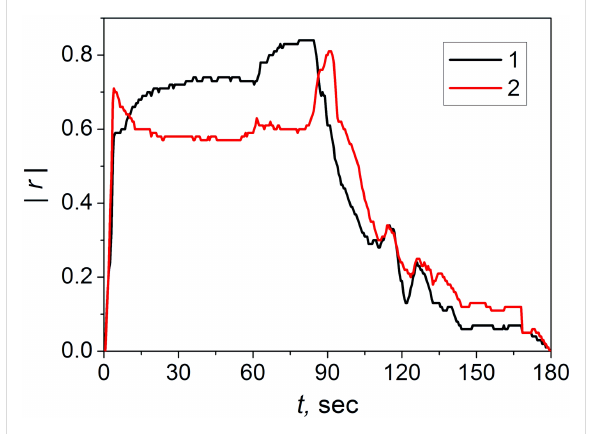
Figure 2: Temporal dependence of the absolute values of the correla- tion coefficient | r |. Here, r describes the correlation between the response voltage values of the breath tests of the patients and the con- centration of serotonin (1, black curve) and cortisol (2, red curve) ac- cording to the medical